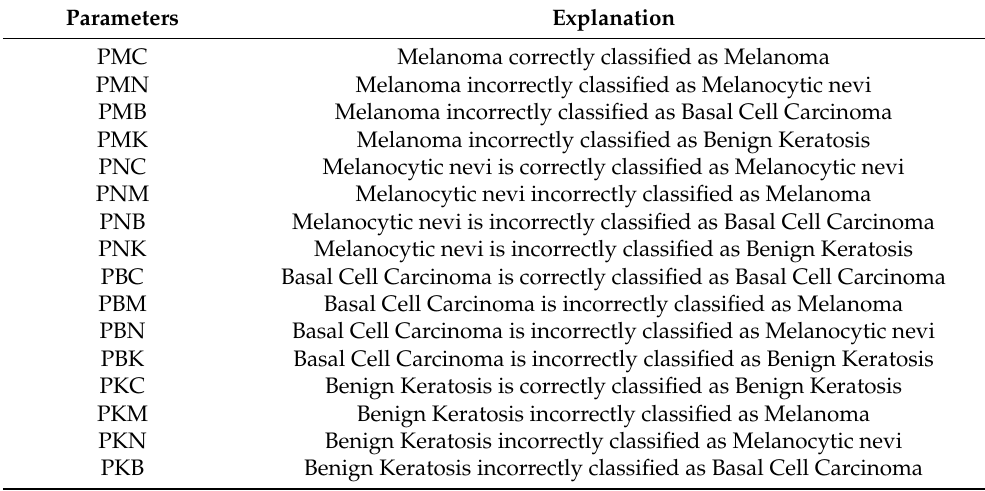
Figure 4. ( a ) SCDNet Model accuracy for training and validation ( b ) SCDNet Model loss for training and validation. Table 3. Confusion Matrix’s Parameters.